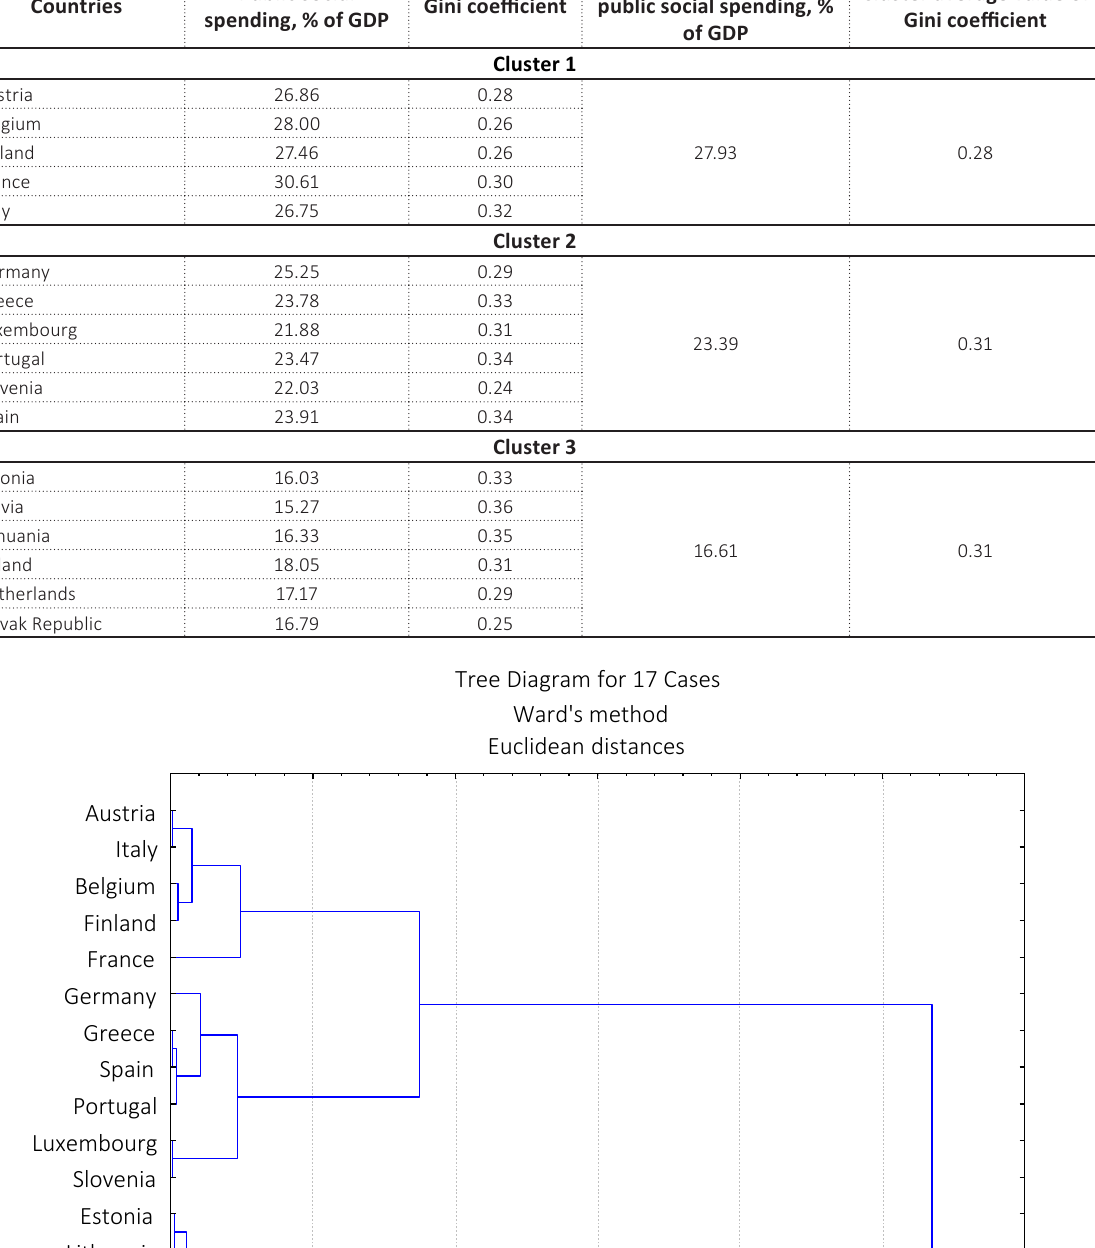
Table 4. Composition of clusters based on the indicators of the scope of social spending and the Gini coefficient and their average values Countries